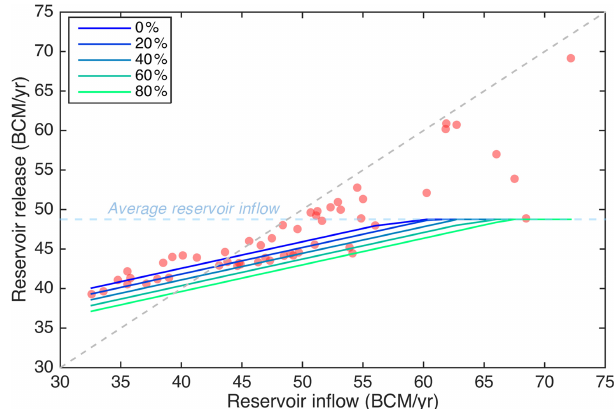
Figure 4. Sample drought mitigation policy with varying ex- ceedance levels ( z = 0%, 20%, 40%, 60%, and